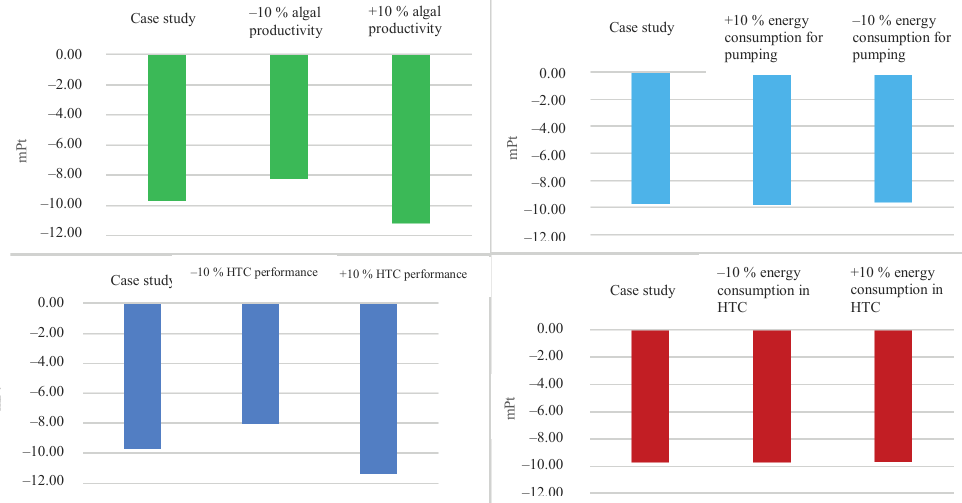
Fig. 5. Results of the sensitivity analyses carried out considering 10 % positive and negative variations in algal productivity, energy consumption for pumping, HTC performance and energy consumption in